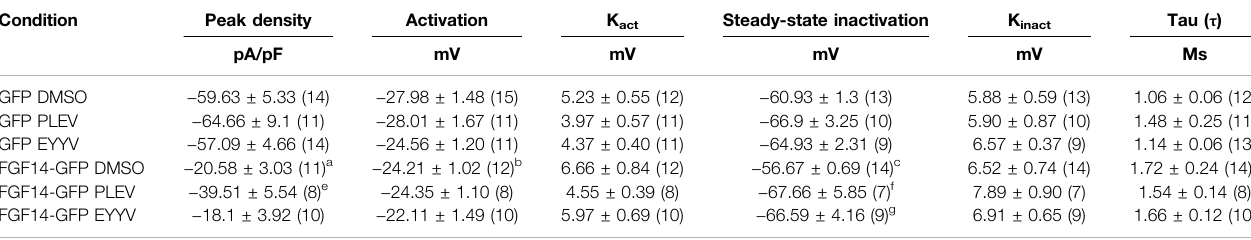
TABLE 1 | Nav1.6 currents in the presence of FGF14 and tetrapeptides PLEV,